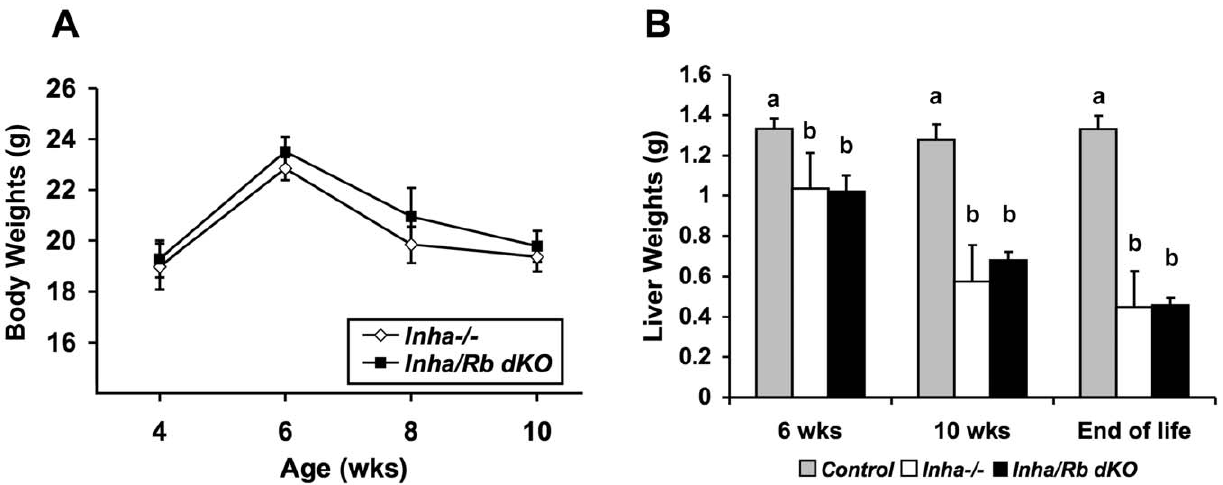
Figure 3. Double knockout of Inha and Rb in Sertoli cells does not significantly affect the activin-induced wasting syndrome. Body weights (A) and liver weights (B) are not significantly different between age-matched Inha 2 / 2 and Inha/Rb dKO mice (p . 0.05). Control liver weights are shown for comparison. Different letters represent statistically different groups.